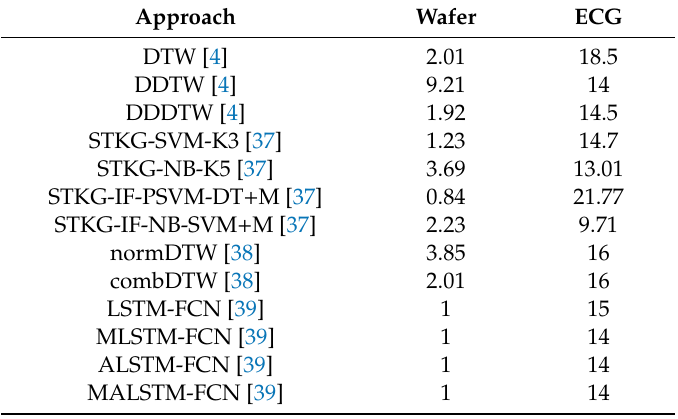
Table 4. Comparison of average error rates (%) of di ff erent methods in Wafer and ECG